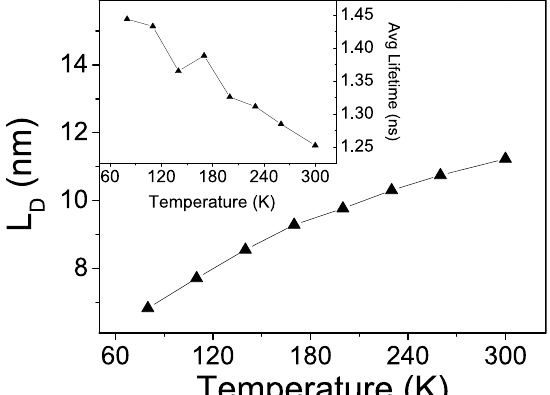
Figure 5. Exciton diffusion lengths in a system composed of alternating layers of P6P and 6 T as a function of temperature. (Inset) Average exciton lifetimes in this